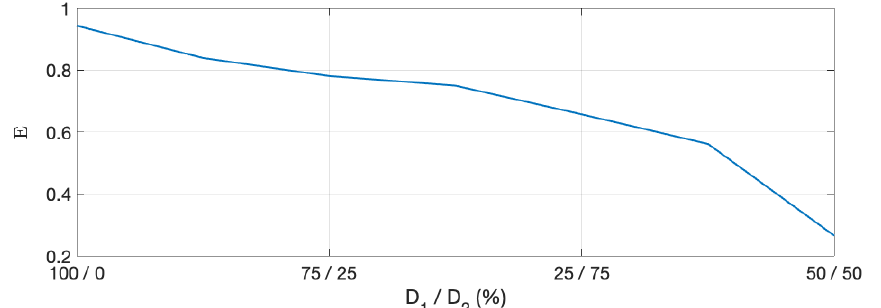
Figure 7. Results from simulation set S 4 in terms of eccentricity variation as a function of different D 1 / D 2 values.